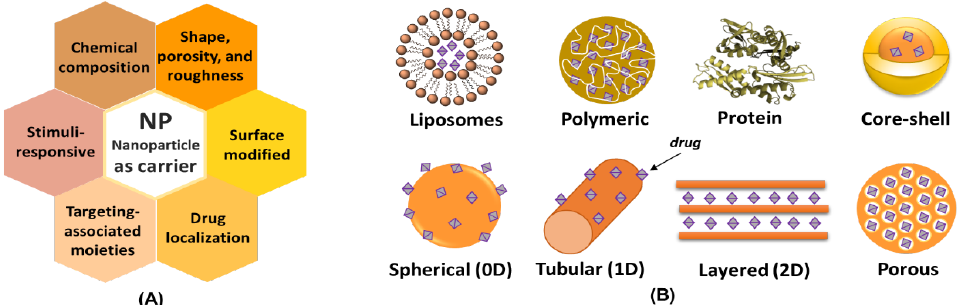
Figure 4. ( A ) Variable chemical and physical parameters considered in the design of the nanoparticles; ( B ) Nanoparticles can have different chemical natures, shapes, porosity, dimensionality etc.